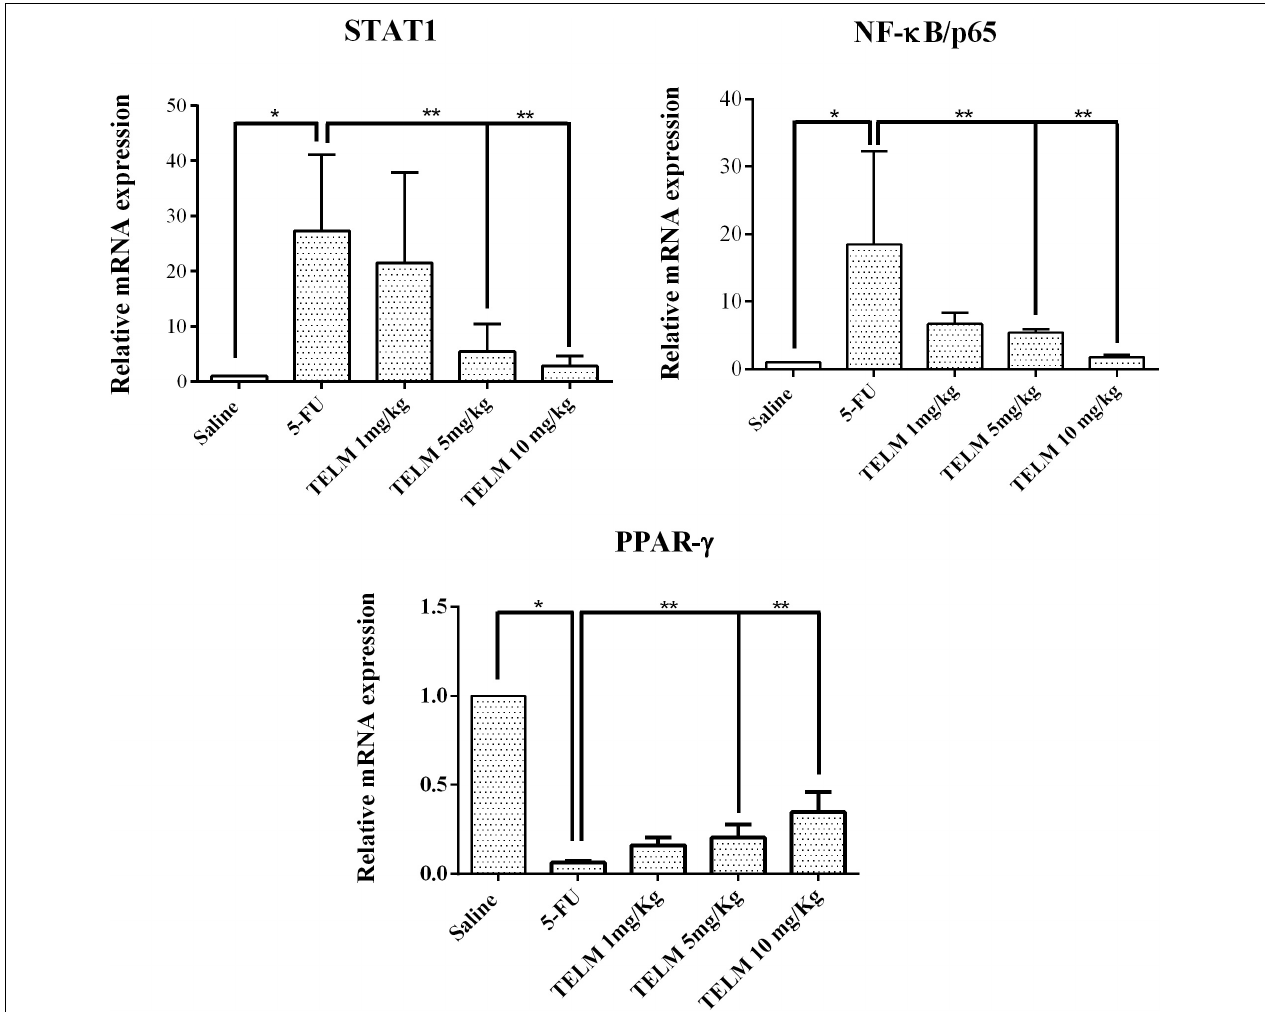
FIGURE 6 | Real-time polymerase chain reaction for the signal transducer and transcription activator 1 (STAT1), nuclear factor NF κ B p65 (NF κ B p65) and peroxisome proliferator-activated receptor gamma (PPAR γ ). 5-Fluorouracil (5-FU) increased the expression of the STAT1 gene and nuclear factor NF κ B p65, compared to the saline group. Telmisartan at 10 mg/kg increased the PPAR γ gene expression and decreased the expression of STAT1 and NF κ B p65 compared to the 5-FU group ( n = 5). ∗ p < 0.05 compared to saline group; ∗∗ p < 0.05 compared to the 5-FU group; analysis of variance with Tukey’s post-test.